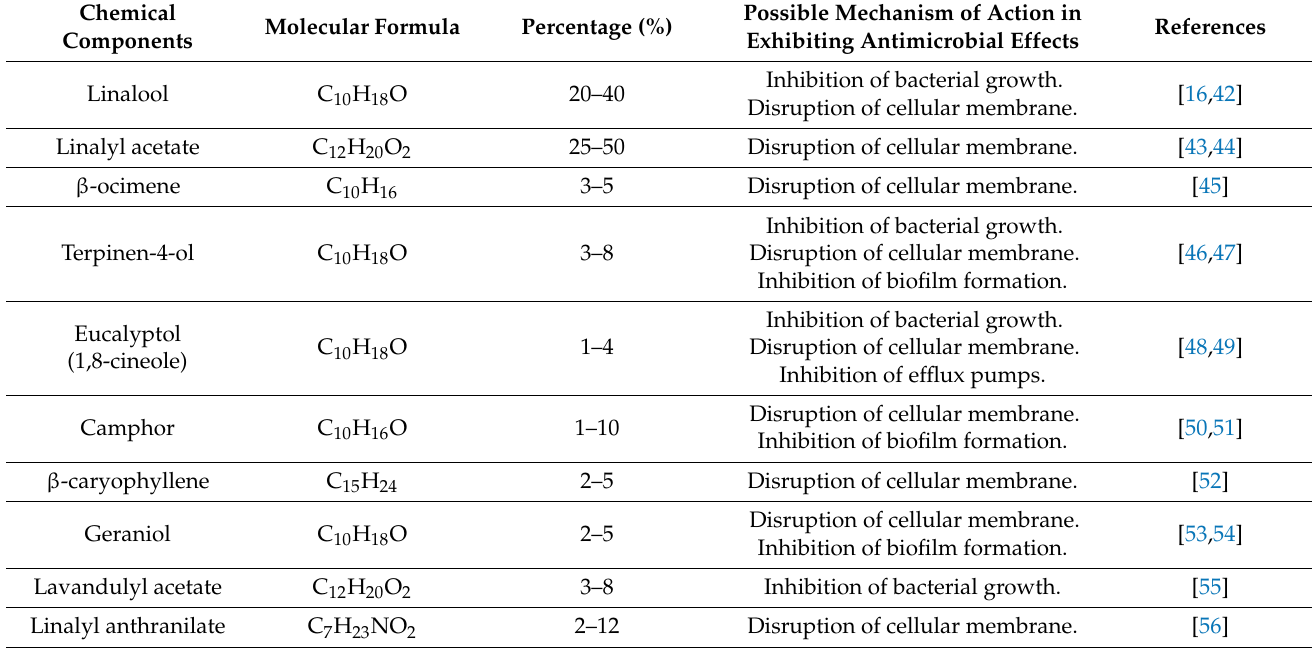
Table 1. Relative abundance of main compounds found in lavender essential oil (LEO) and their antimicrobial effects from different quantitative and qualitative